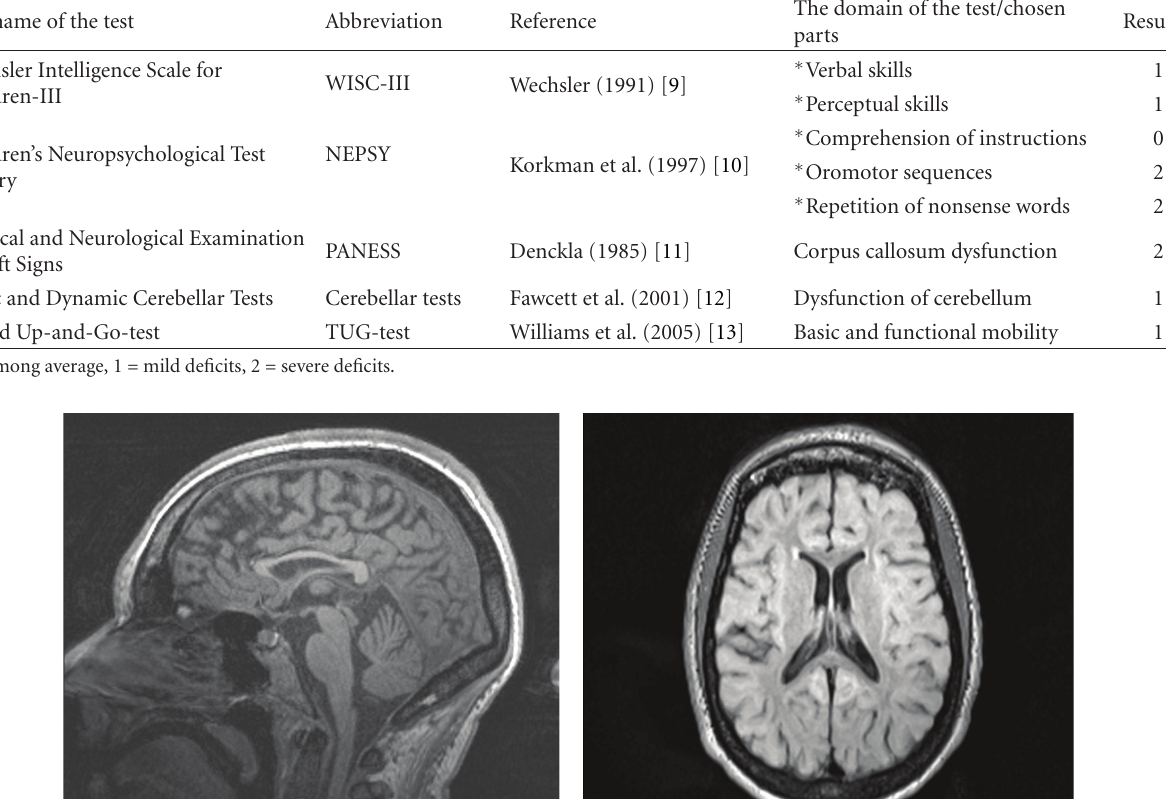
of the cervical cord were normal. There was no enlargement of the ventricles or signs of cortical atrophy. The MRI findings at 30 years of age were mild (Figure